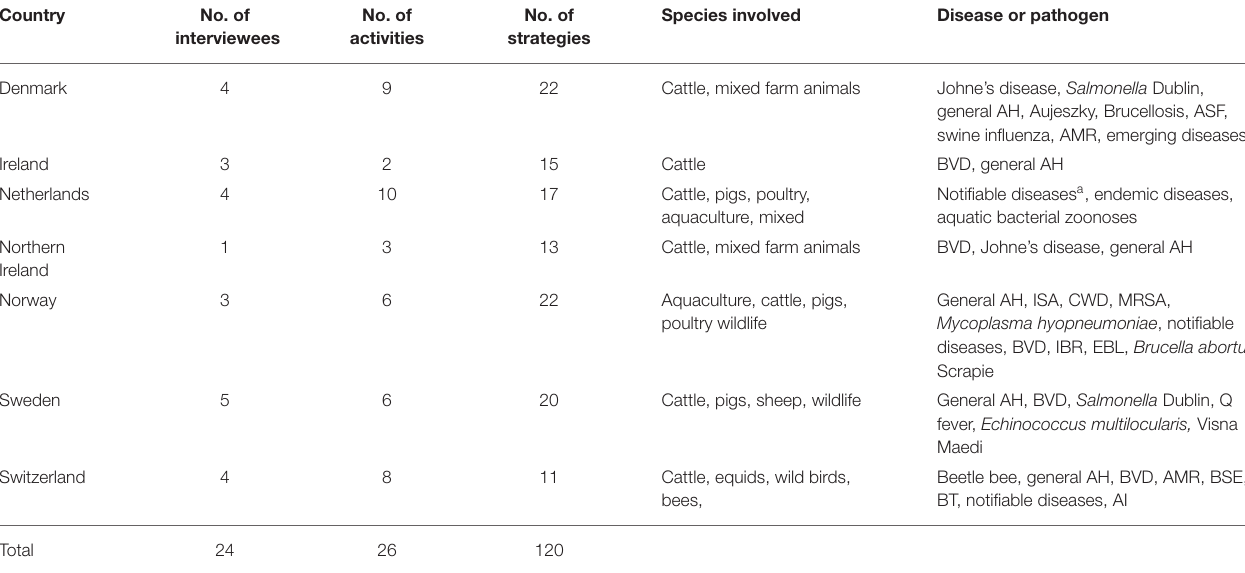
TABLE 1 | Overview of the context within which strategies aimed at influencing behavior have been implemented in animal health activities in seven European countries.